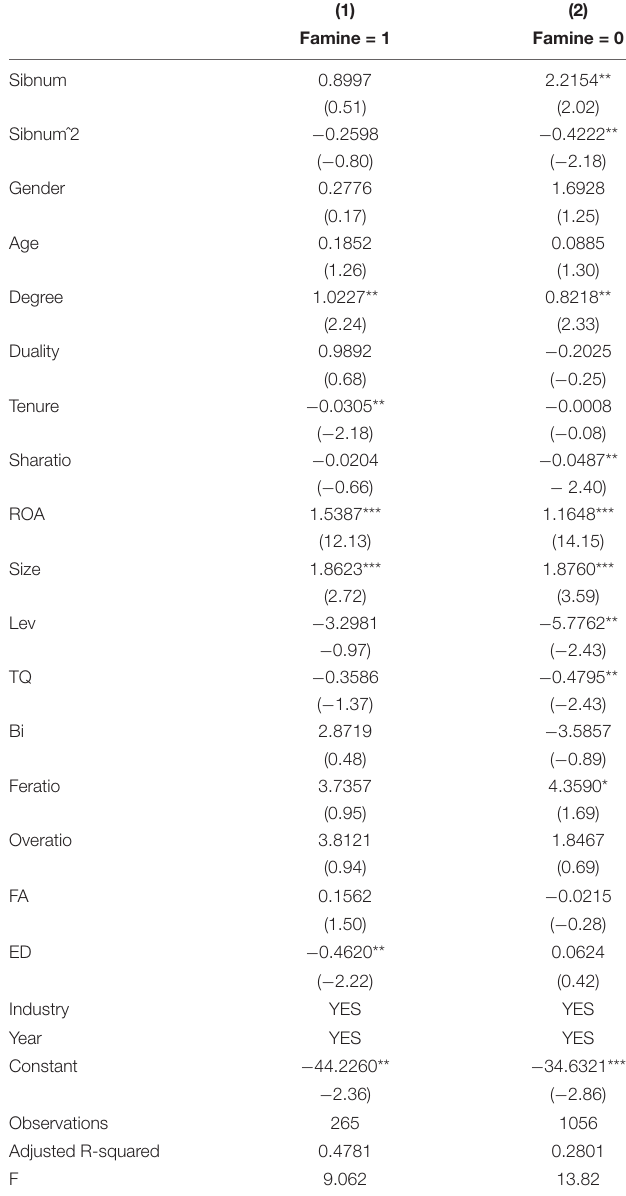
TABLE 9 | The influence of executives’ famine